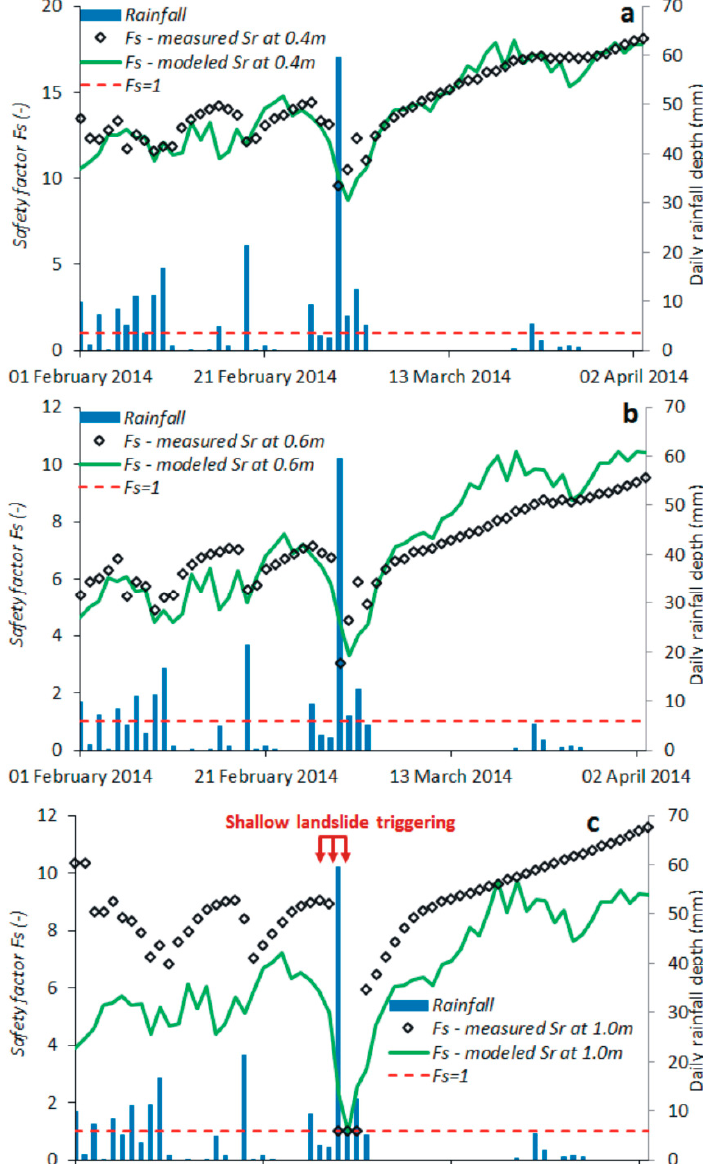
Figure 9. Comparison between the safety factor obtained from the measured and modeled values of the degree of the soil saturation for the period between 1 February 2014 and 3 April 2014 at various depths below the ground level: ( a ) 0.4 m; ( b ) 0.6 m; and ( c ) 1.0 m.